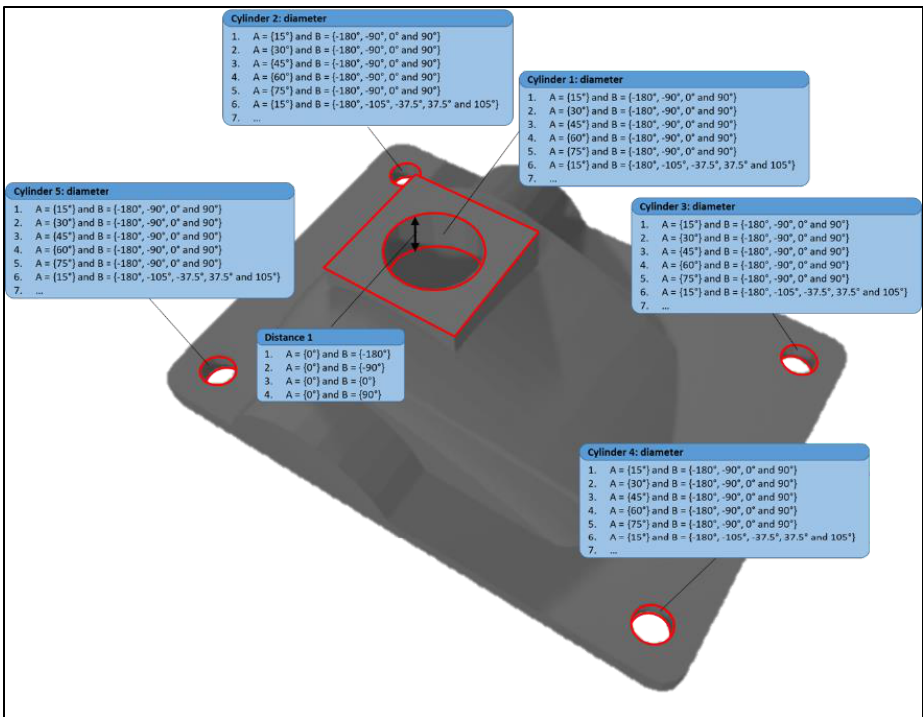
Figure 5. An STL file combined with different scan strategies for the critical tolerance features.